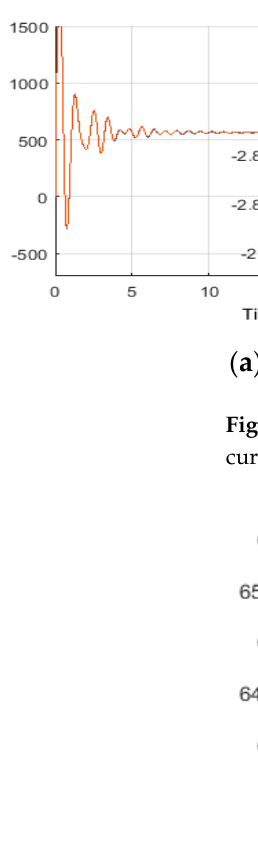
Figure 23. Test inputs of the observer for Scenario-6: ( a ) Top drive motor voltage, ( b ) Applied